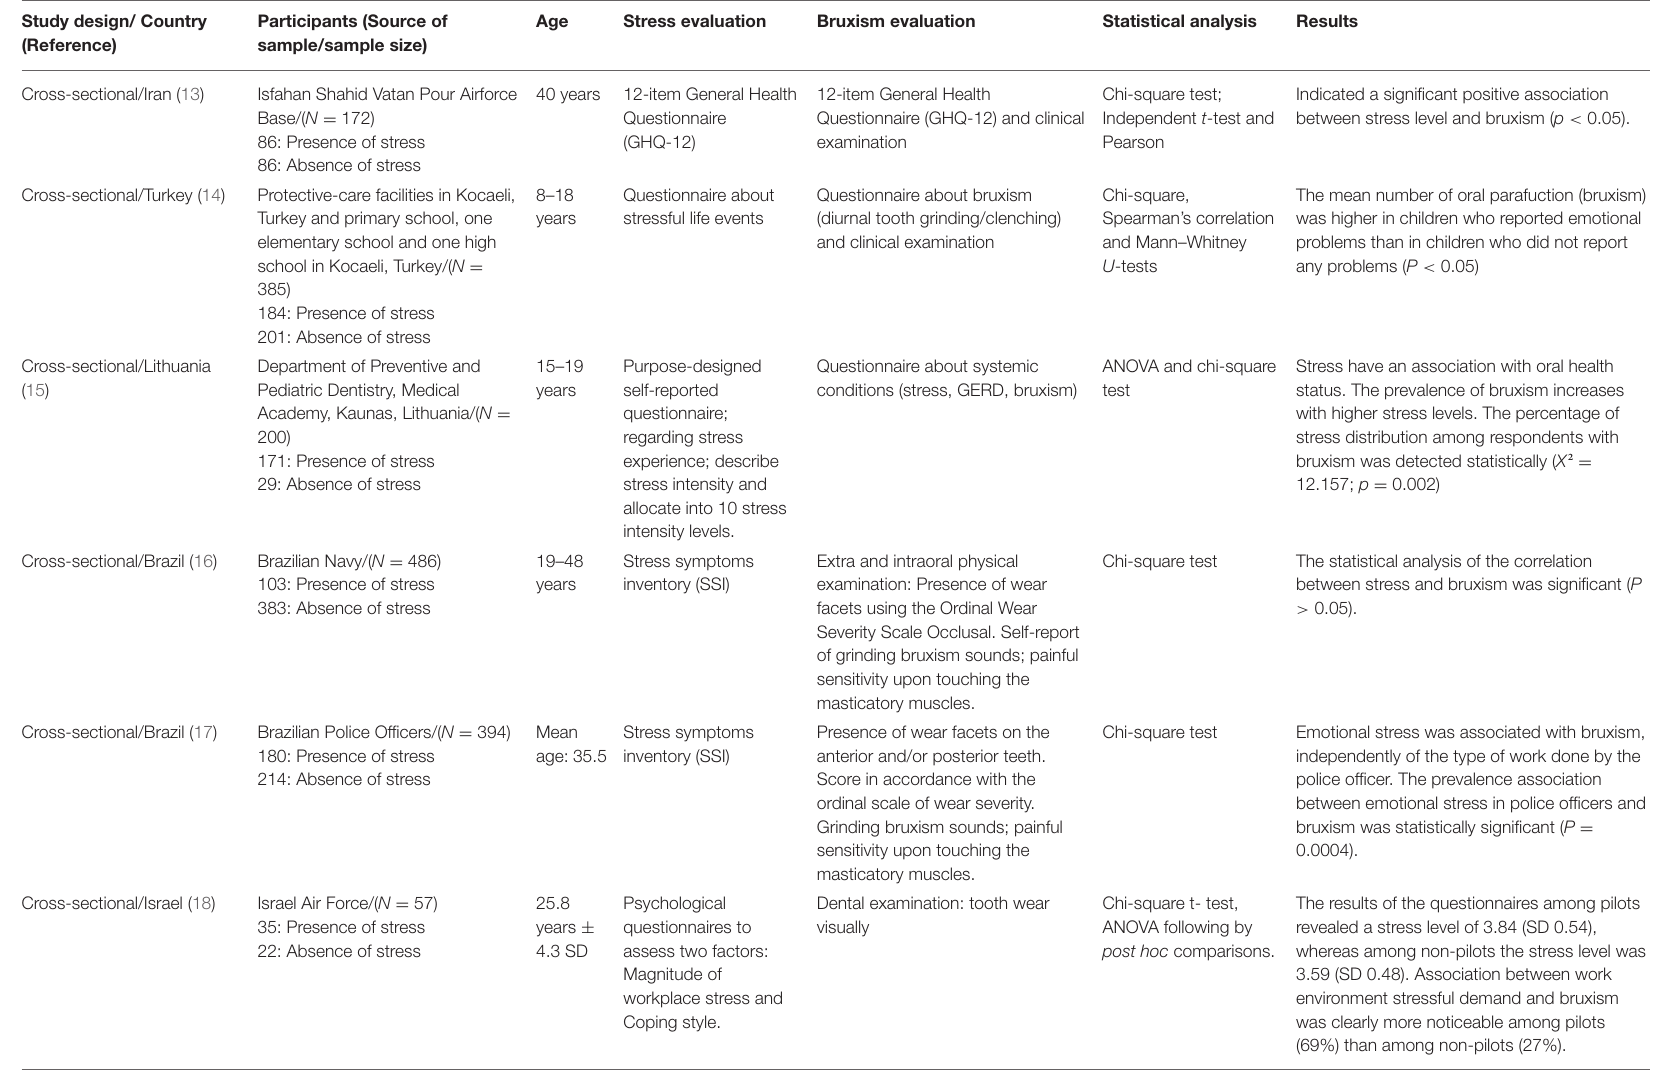
TABLE 1 | Summary of characteristics and results of the included